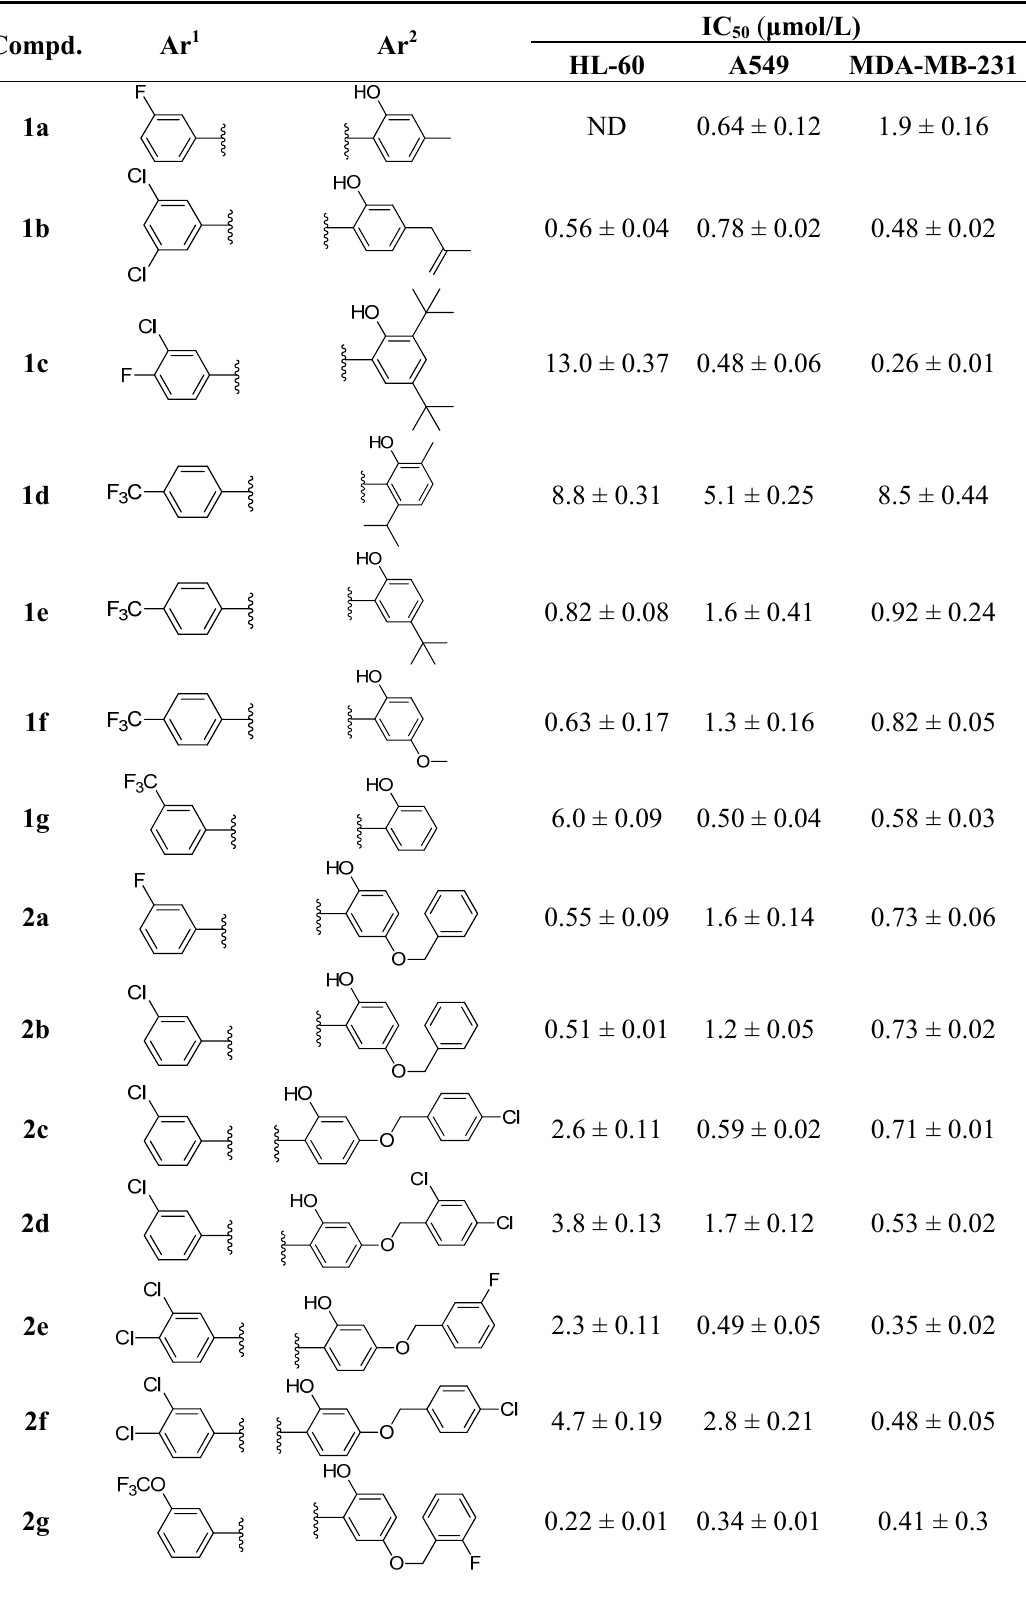
Table 1. Structures and cytotoxicity of compounds 1a – g , 2a – k , 3a – e and 4a – c against HL-60, A549 and MDA-MB-231 cell lines.